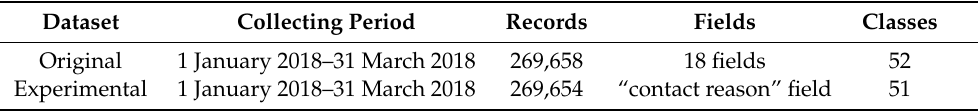
Table 2. The statistics of the original and experimental dataset.